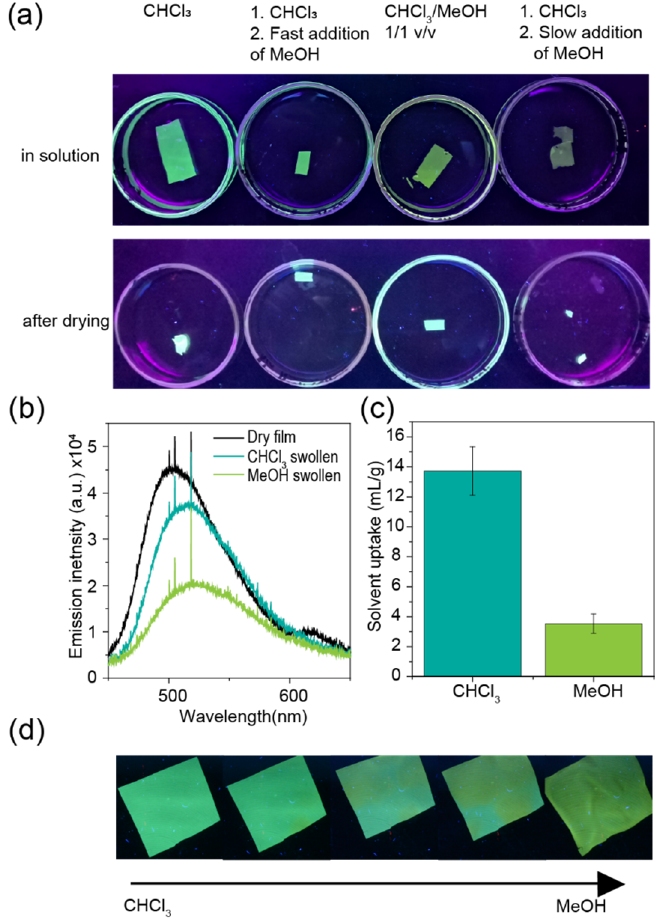
Figure 6. ( a ) Swelling experiments with samples of PU-D/A films. The top row shows images of solvent-cast films that were swollen by addition of (from left to right) CHCl 3 , CHCl 3 with an excess of MeOH, an MeOH/CHCl 3 (50:50 v / v %) mixture, and CHCl 3 followed by the slow addition of MeOH. The bottom row shows the same samples after drying by solvent evaporation at room tem- perature. ( b ) Emission spectra ( λ ex = 305 nm) of a dry (black line), CHCl 3 -swollen (turquoise line), and MeOH-swollen (green line) film of PU-D/A . ( c ) MeOH and CHCl 3 uptake of PU-D/A films de- termined gravimetrically after swelling of the samples for 5 h. Values represent averages of three individual measurements ± standard error of mean. ( d ) Photographs of a solvent-cast PU-D/A film that was swollen in CHCl 3 (left) and images taken during dropwise addition of methanol. All images were recorded under UV light illumination (365 nm). The images show clearly that the solvatochromic effect is retained for PU-D/A films. Upon increasing the solvent polarity, the fluorescence intensity is reduced and the emis- sion color is red-shifted (Figure 6b), as indicated by the green emission color of the CHCl 3 - swollen samples changing to yellow upon the slow addition of methanol. After drying, the light blue fluorescence of the solvent-cast films is restored, which indicates that the effect is neither driven by the extent of swelling (CHCl 3 > MeOH > dry film) (Figure 6c) or by aggregation-induced quenching effects. To further demonstrate the solvatochromic change in the emission, a solvent-cast PU-D/A film was swollen in CHCl 3 and the emis- sion was monitored during the dropwise addition of methanol (Figure 6d). The still im- ages from the recorded video show that the addition of methanol results in an immediate shift in fluorescence color with a concomitant decrease in emission intensity, corroborat- ing the conclusion that increased polarity leads to an association of the donor and acceptor moieties in these physically cross-linked polymer films, presumably under the formation of intramolecular loops.